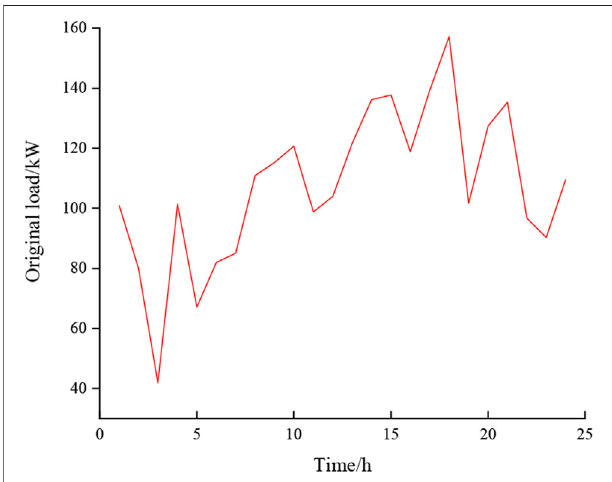
FIGURE 4 | Curve of the original daily load.